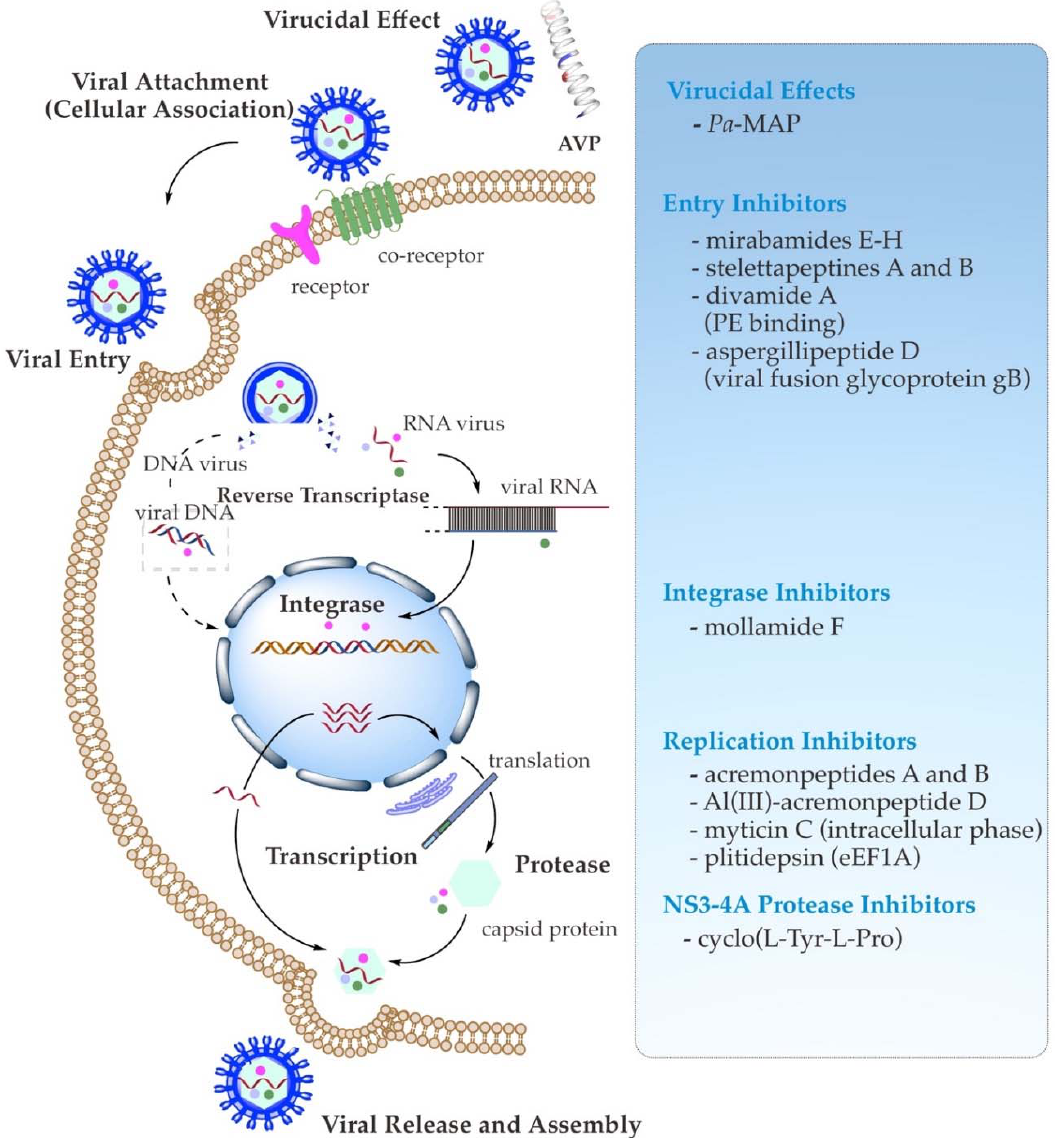
Figure 1. Schematic summary of known antiviral mechanisms of the recently reported marine AVPs.